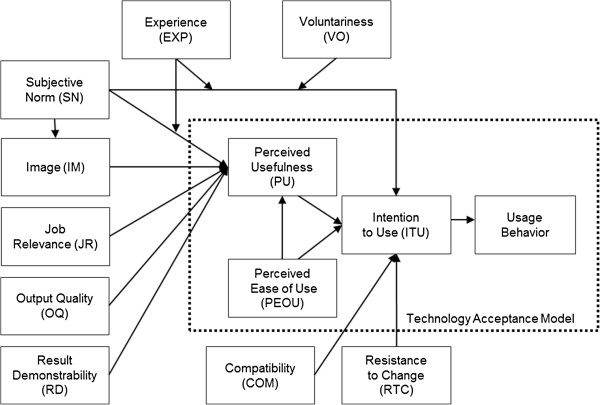
Adapted TAM2 model.